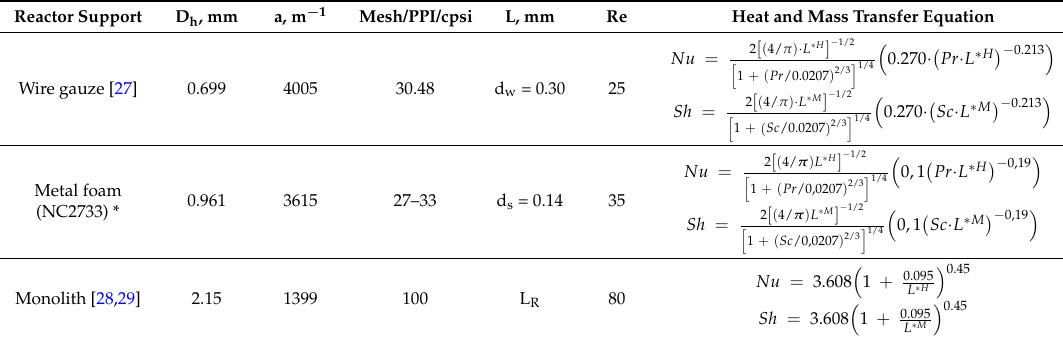
Table 3. Reactor parameters used during the modelling: geometric parameters of reactor support, average Reynolds numbers, heat and mass transfer correlations (gas velocity v m = 1